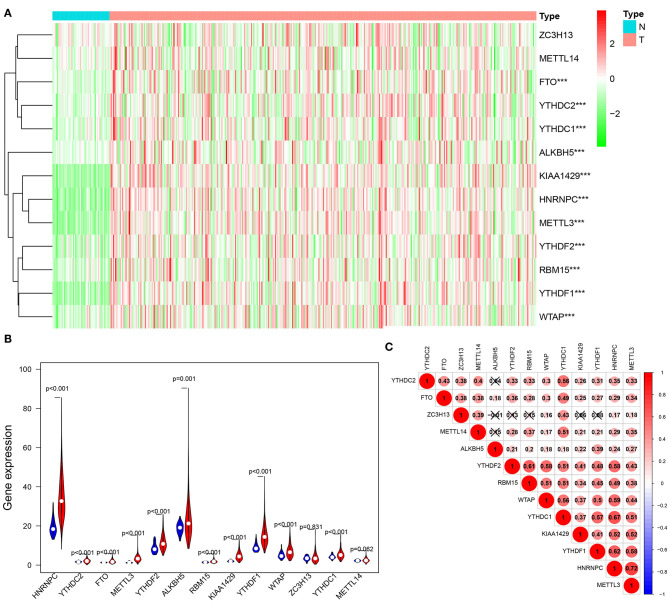
Expression of m6A modification regulators in HCC. (A) The heatmap visualizes the expression levels of m6A RNA modification regulators in each sample. “N” represents normal samples and “T” represents tumor samples. Green represents low expression and red represent high expression. (B) The vioplot shows the differentially m6A RNA modification regulators in HCC. Blue represents normal sample and red represents HCC sample. White spot represents the median value of expression. (C) Spearman correlation analysis of the 13 m6A RNA modification regulators in HCC. ***p < 0.001.